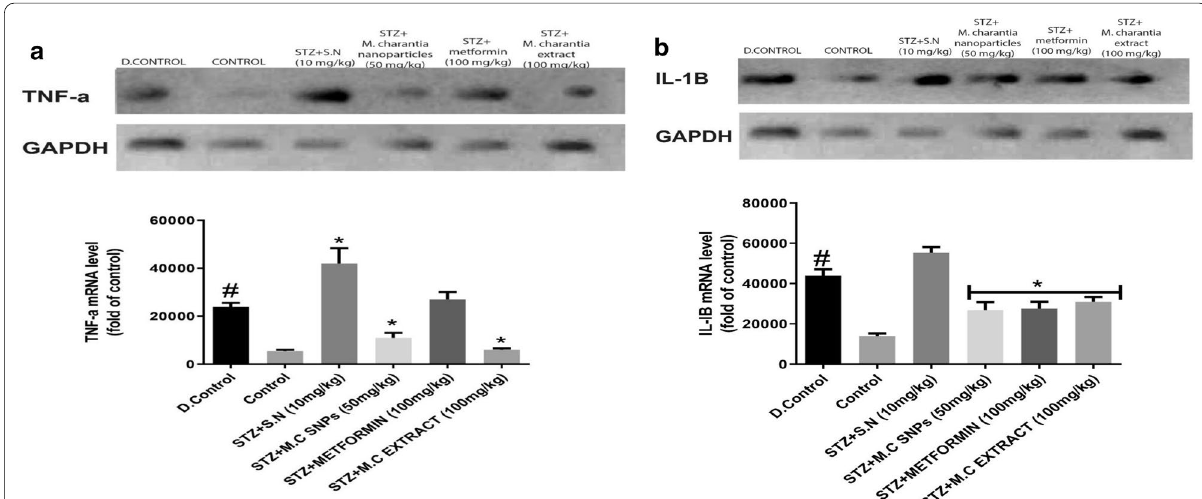
Fig. 3 a Snapshot representation of the densitometric evaluation of agarose gel electrophoresis of the reverse transcriptase polymerase chain reaction (RT-PCR) analysis of TNF-α expression. *represent statistical difference to control ( p < 0.05) while # represent statistical difference to Diabetic control ( p < 0.05). b Snapshot representation of the densitometric evaluation of agarose gel electrophoresis of the reverse transcriptase polymerase chain reaction (RT-PCR) analysis of IL-1β expression. *represent statistical difference to control ( p < 0.05) while # represent statistical difference to Diabetic control ( p <